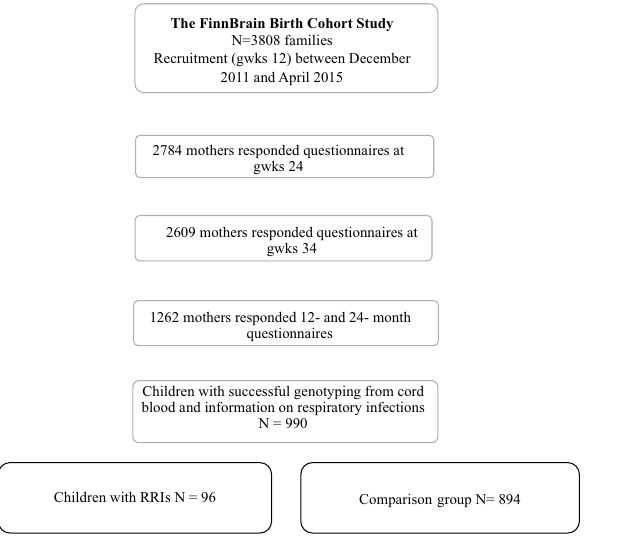
Figure 1. Flowchart of study population. gwk gestational week, RRIs recurrent respiratory